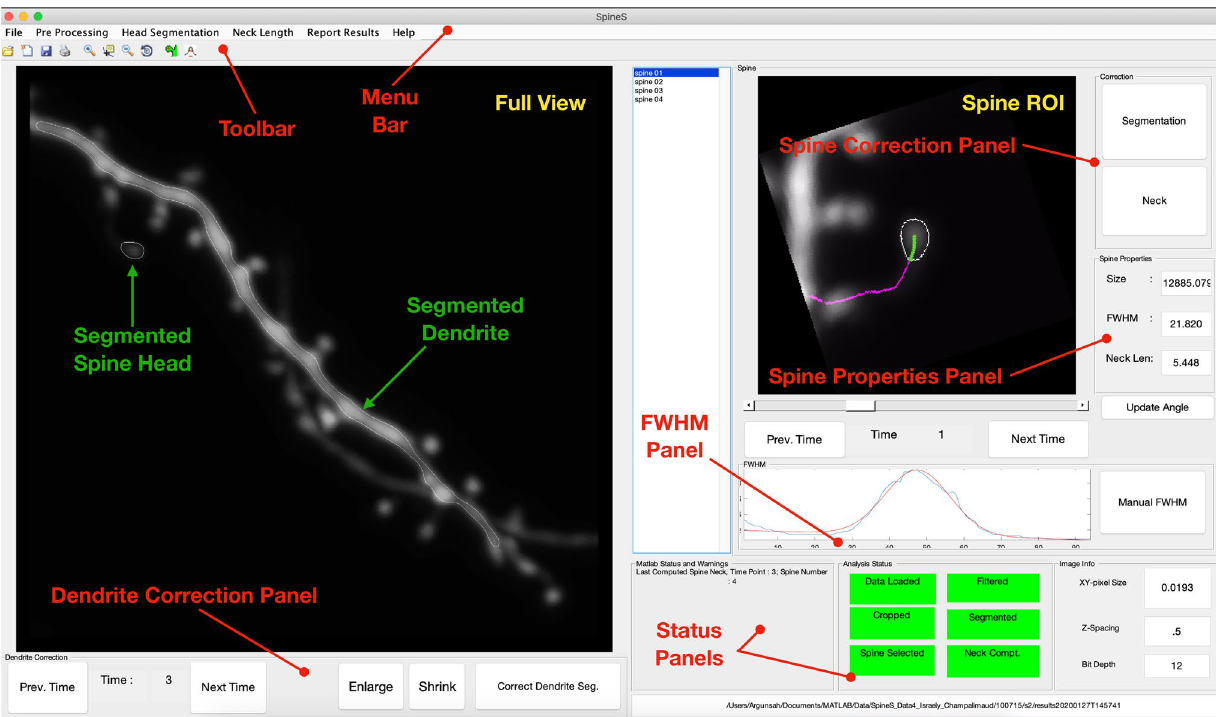
Figure 1. The SpineS GUI allows automatic analysis of dendritic spines in combination with interactive manual correction tools. The Full View pane shows a maximum intensity projection (MIP) of the first time point of the dendrite to be analyzed after loading the data. SpineS automatically detects various dendritic features, and segments dendrites and dendritic spines for all time points. Detected feature points and segmentations are used to quantify the number of spines, spine volumes, and spine neck lengths. There are several tools for users to correct mistakes made by the